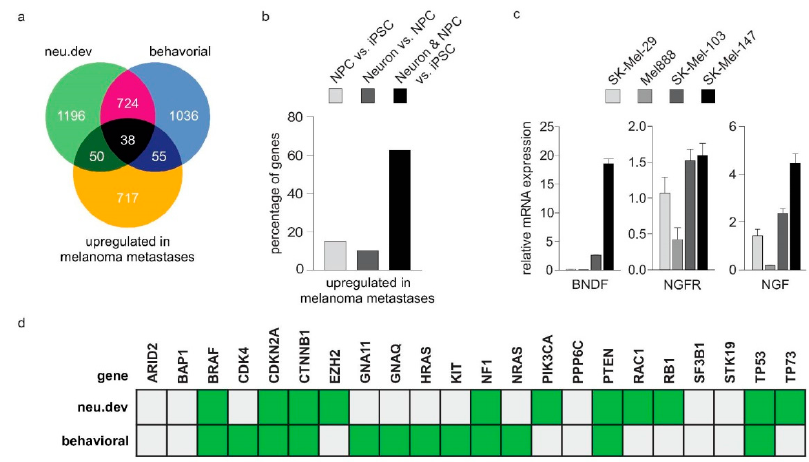
Figure 5. Melanoma progression is associated with upregulation of neuronal factors. ( a , b ) Nervous system-related genes ( a ) and genes involved in early (NPC) and late stages (neurons) of neuronal differentiation of iPSCs ( b ) are upregulated in metastatic melanoma versus primary lesions. ( c ) Neurogenesis and neoneurogenesis factors are upregulated in highly invasive SK-Mel-103 and SK-Mel-147 versus the less invasive melanoma cell lines SK-Mel-29 and Mel-888. ( d ) The majority of well-established melanoma drivers [32] and inducers of metastasis initiation [33] are indispensable for neuronal development and/or neurological function.